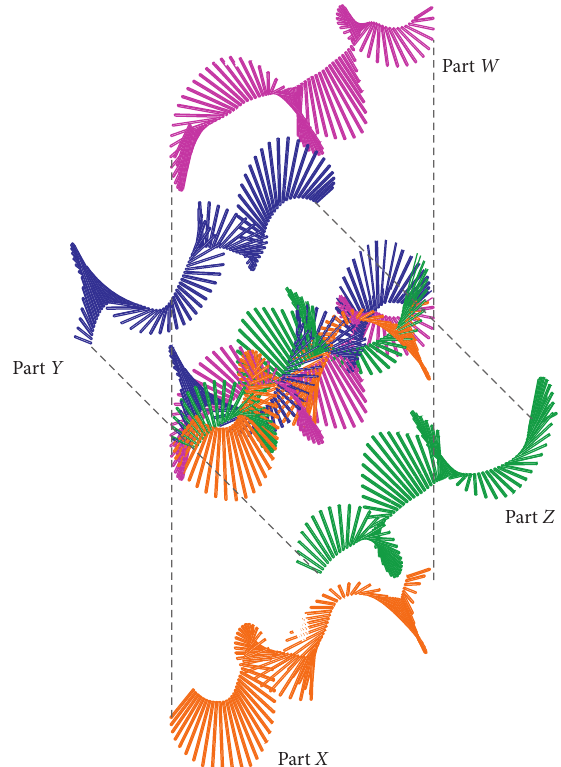
Figure 14: Making other parts by mirroring one part horizontally and vertically (source: drawing by the research team).